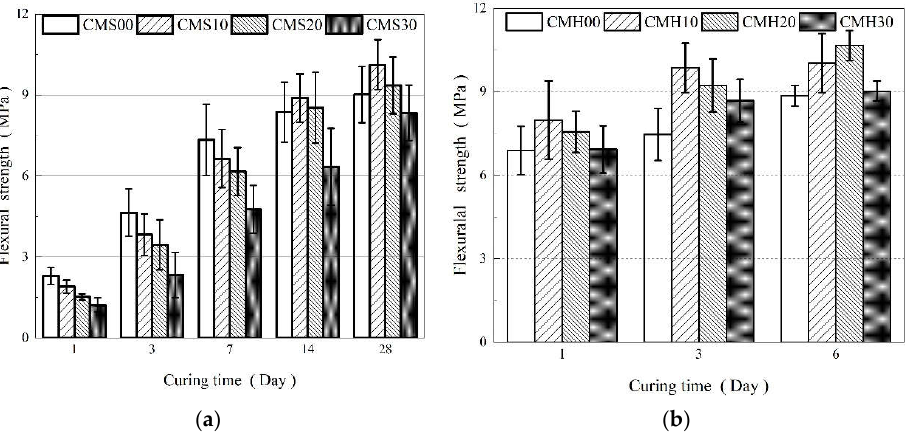
Figure 3. Flexural strength development of the composite cement-based material under standard curing ( a ) and high temperature curing ( b ).